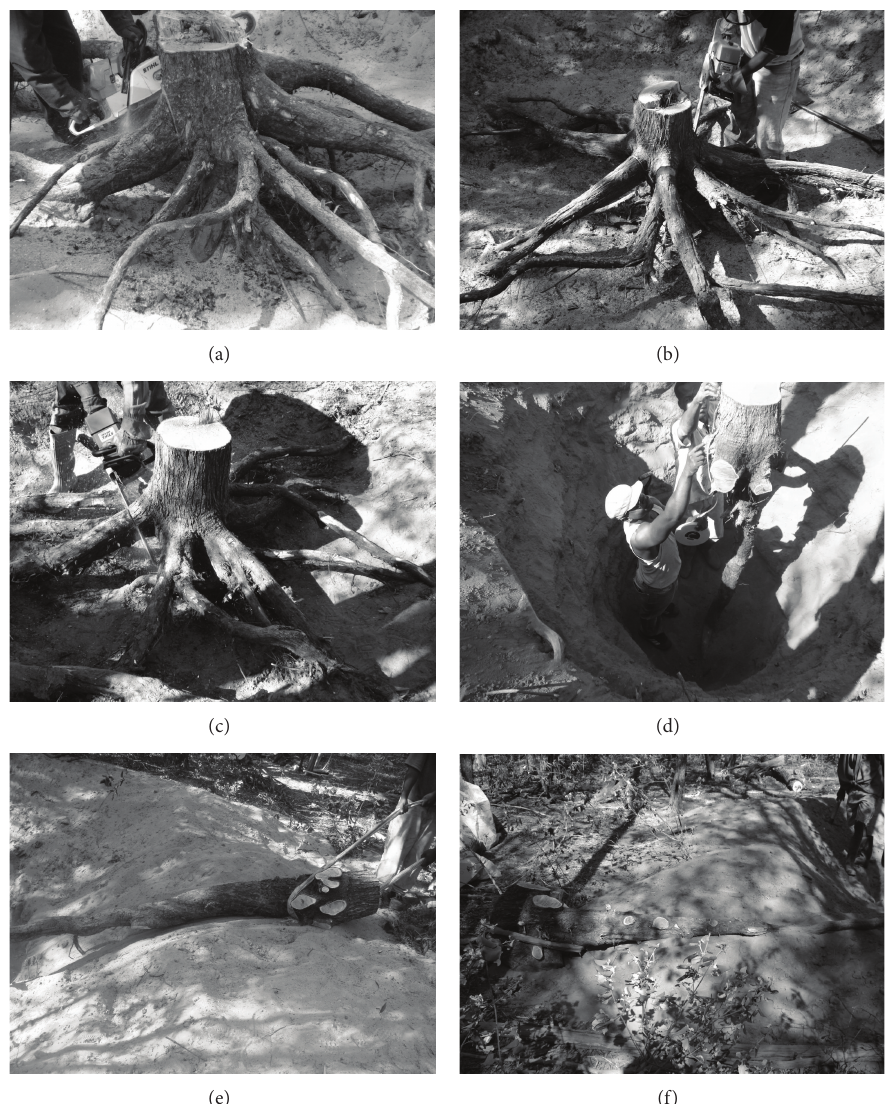
Figure 1: Separation of lateral roots from the root collar/taproot (a, b, and c) and removal of the taproot including the root collar and the stump (d, e, and